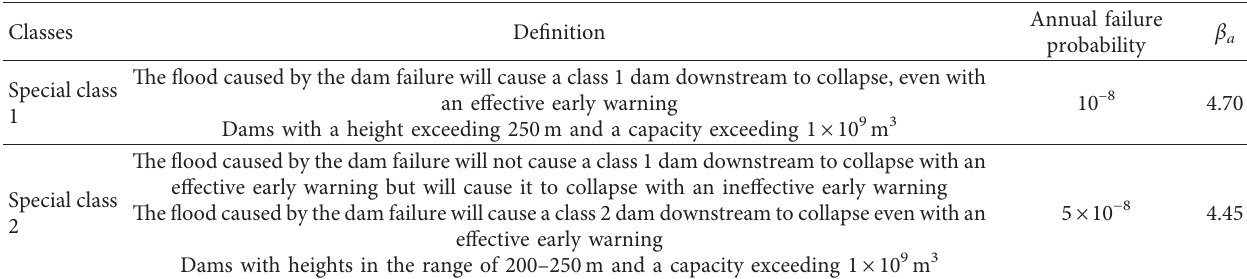
Table 4: Definition of special class structures.